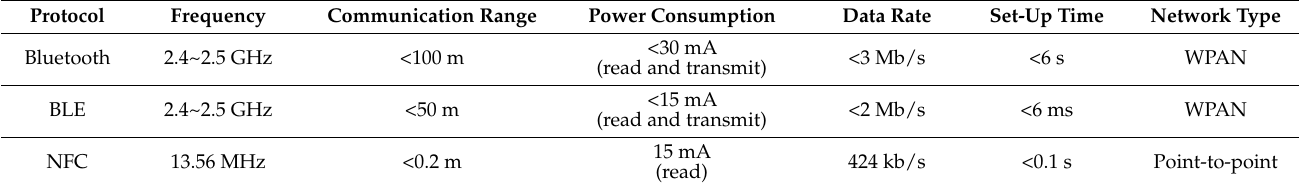
Table 1. Summary of characteristics of Bluetooth, BLE, and NFC